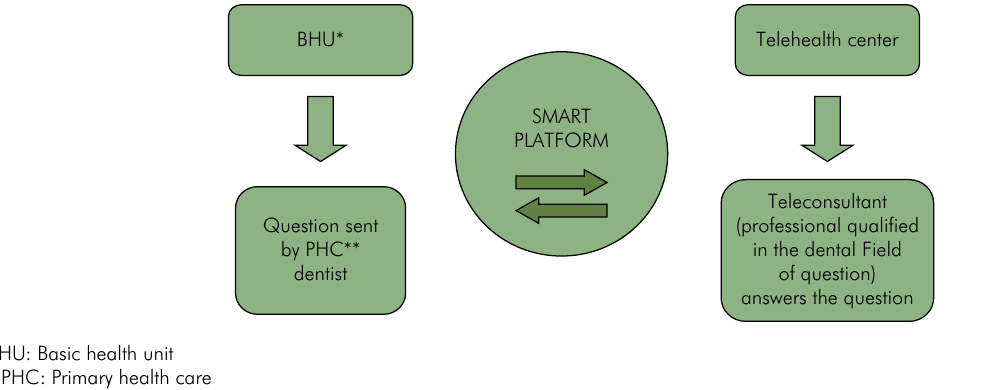
Figure. Flowchart of the order of teleconsulting distribution